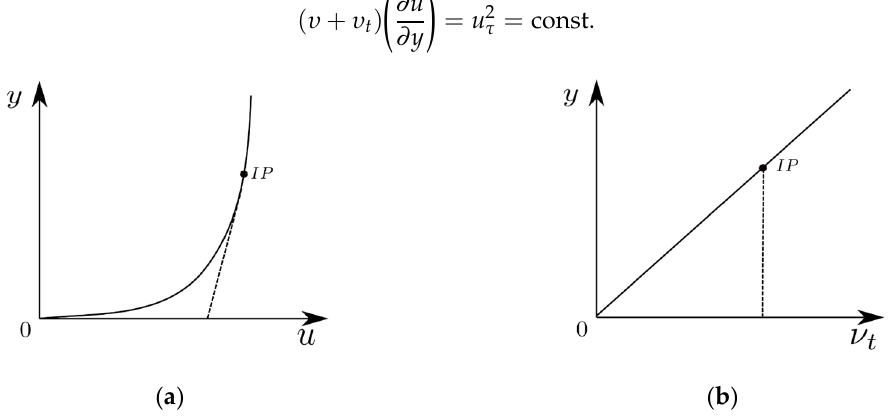
Figure 2. ( a ) Velocity profile; ( b ) Eddy viscosity profile. The solid lines are the original profiles. The dash lines are the modified profiles between the image point and the wall.